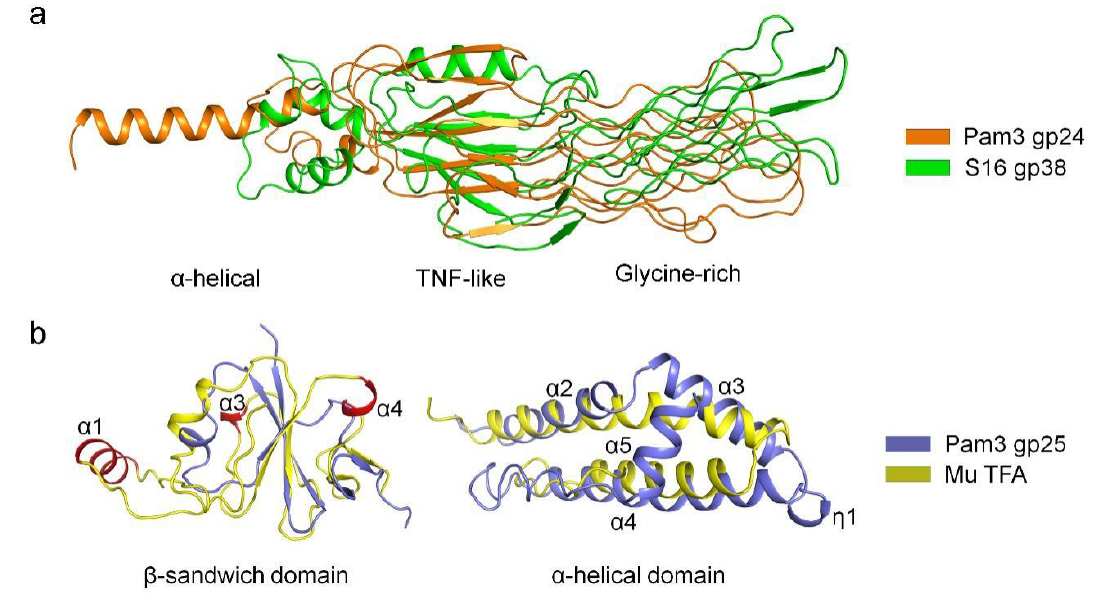
Figure 4. Structural comparisons of gp24 and gp25 with homologs. ( a ) Superposition of Pam3 gp24 against gp38 of phage S16 (PDB 6F45). The structures are shown in cartoon, and colored orange for gp24 and green for gp38. The three domains of gp24 are labeled. ( b ) Superposition of the two domains of Pam3 gp25 against those from phage Mu TFA (left panel for the β -sandwich domain and right panel for the α -helical domain). The model of the C-terminal domain of phage Mu TFA was predicted by AlphaFold2 (right panel). The structures are shown in cartoon and colored differently, with the secondary structural elements of gp25 labeled sequentially. The additional helices α 1, α 3 and α 4 of the N-terminal domain of phage Mu TFA are colored red and labeled.